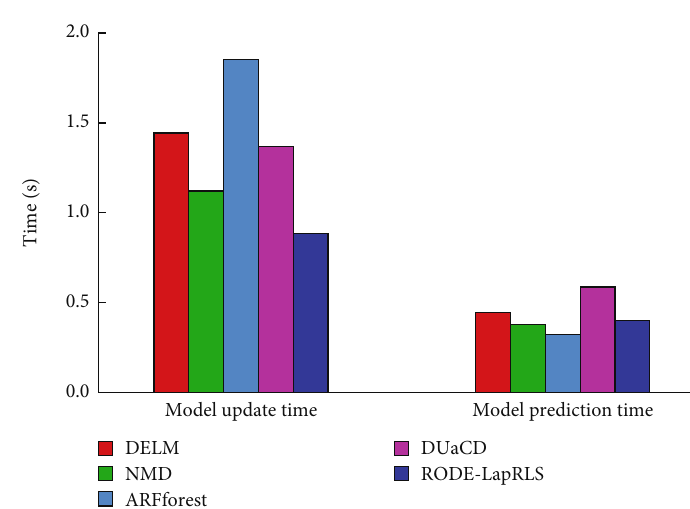
Figure 6: Model e ffi ciency